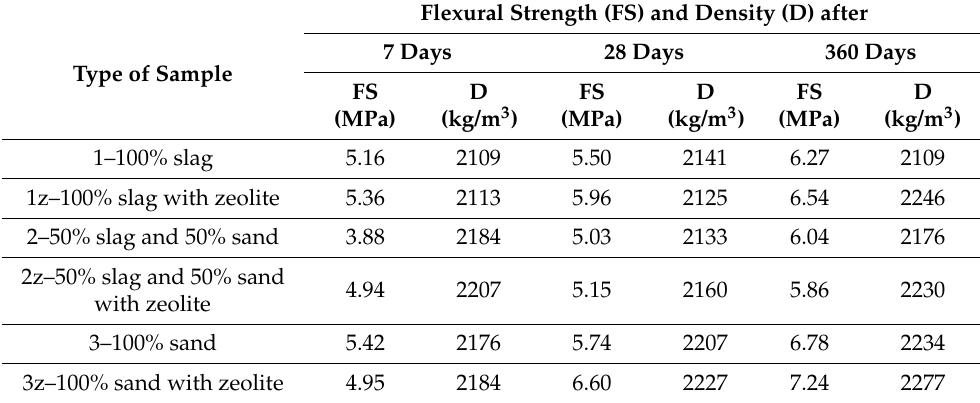
Table 3. Flexural strength and density of samples after 7, 28, and 360 days.